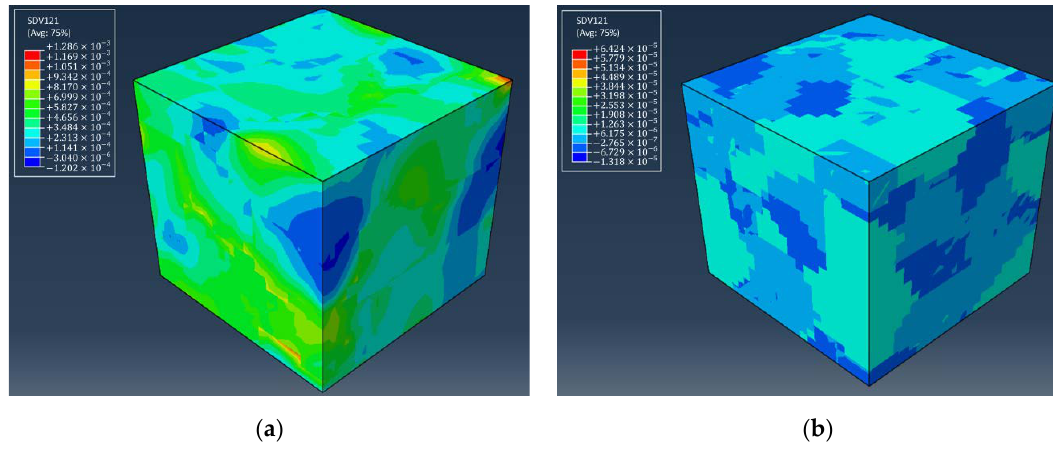
Figure 7. Plastic slip accumulation for ( a ) one large grain RVE, and ( b ) one small grain RVE.